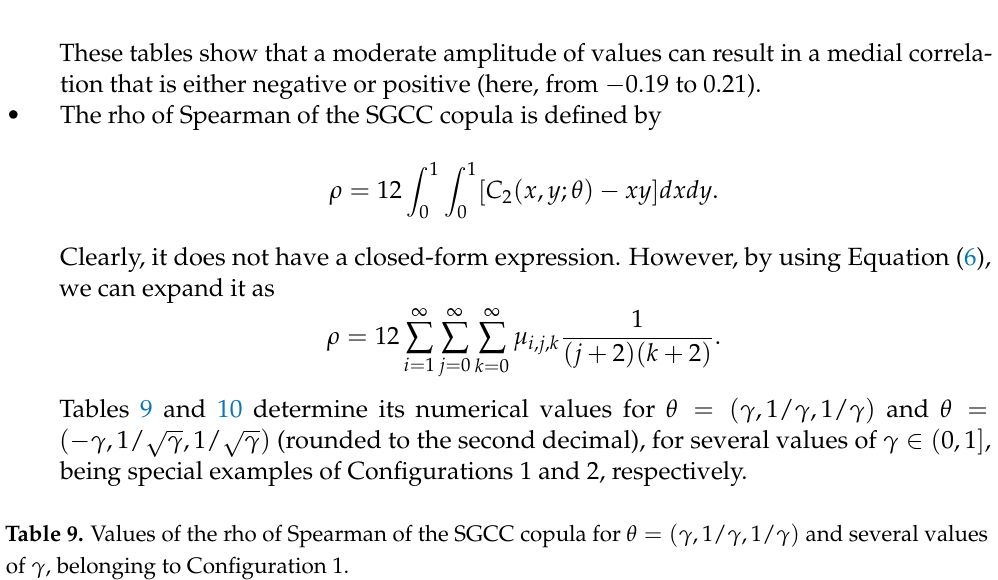
Table 9. Values of the rho of Spearman of the SGCC copula for θ = ( γ ,1/ γ ,1/ γ ) and several values of γ , belonging to Configuration 1.